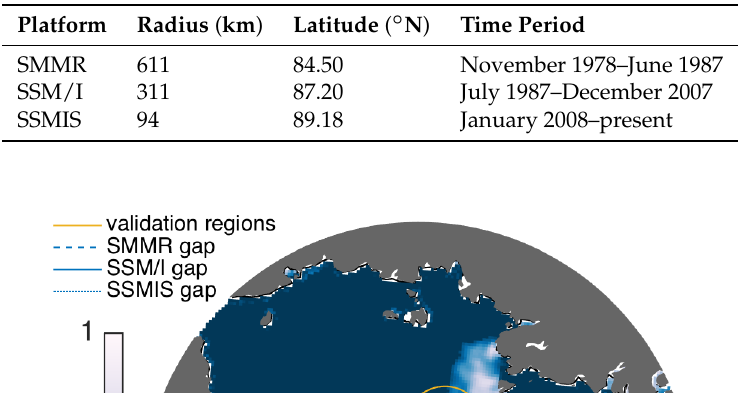
Table 1. For the circular “pole hole mask” covering the polar data gap: the satellite platform, the hole radius, the latitude of the hole’s outer edge, and the applicable time periods.